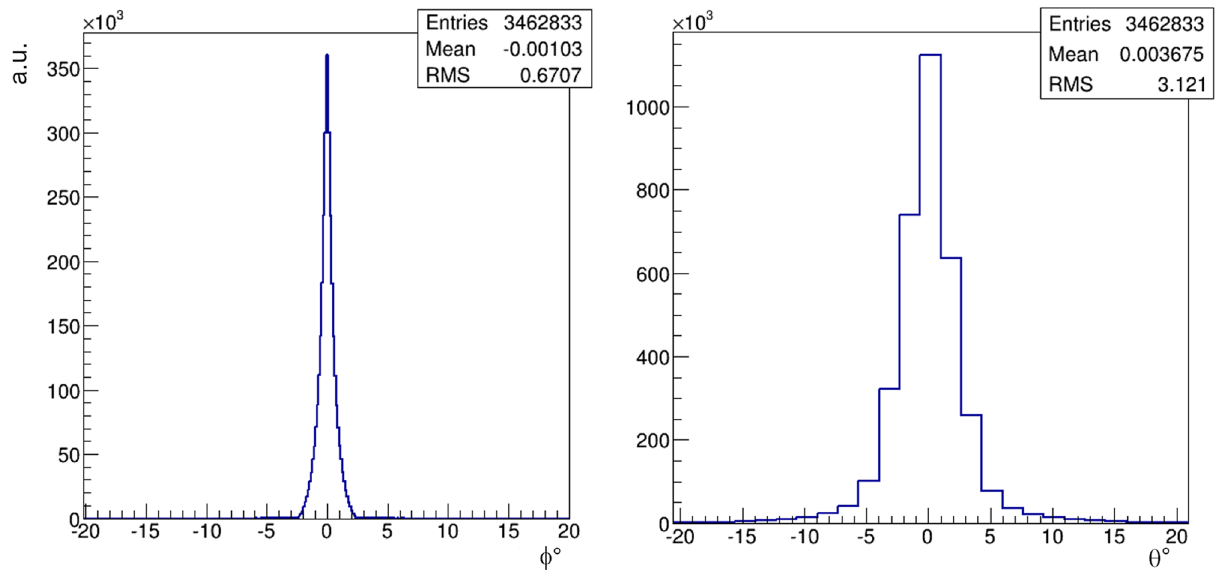
Figure 9. Expected average angular resolutions of the reconstructed azimuth (left) and zenith angle